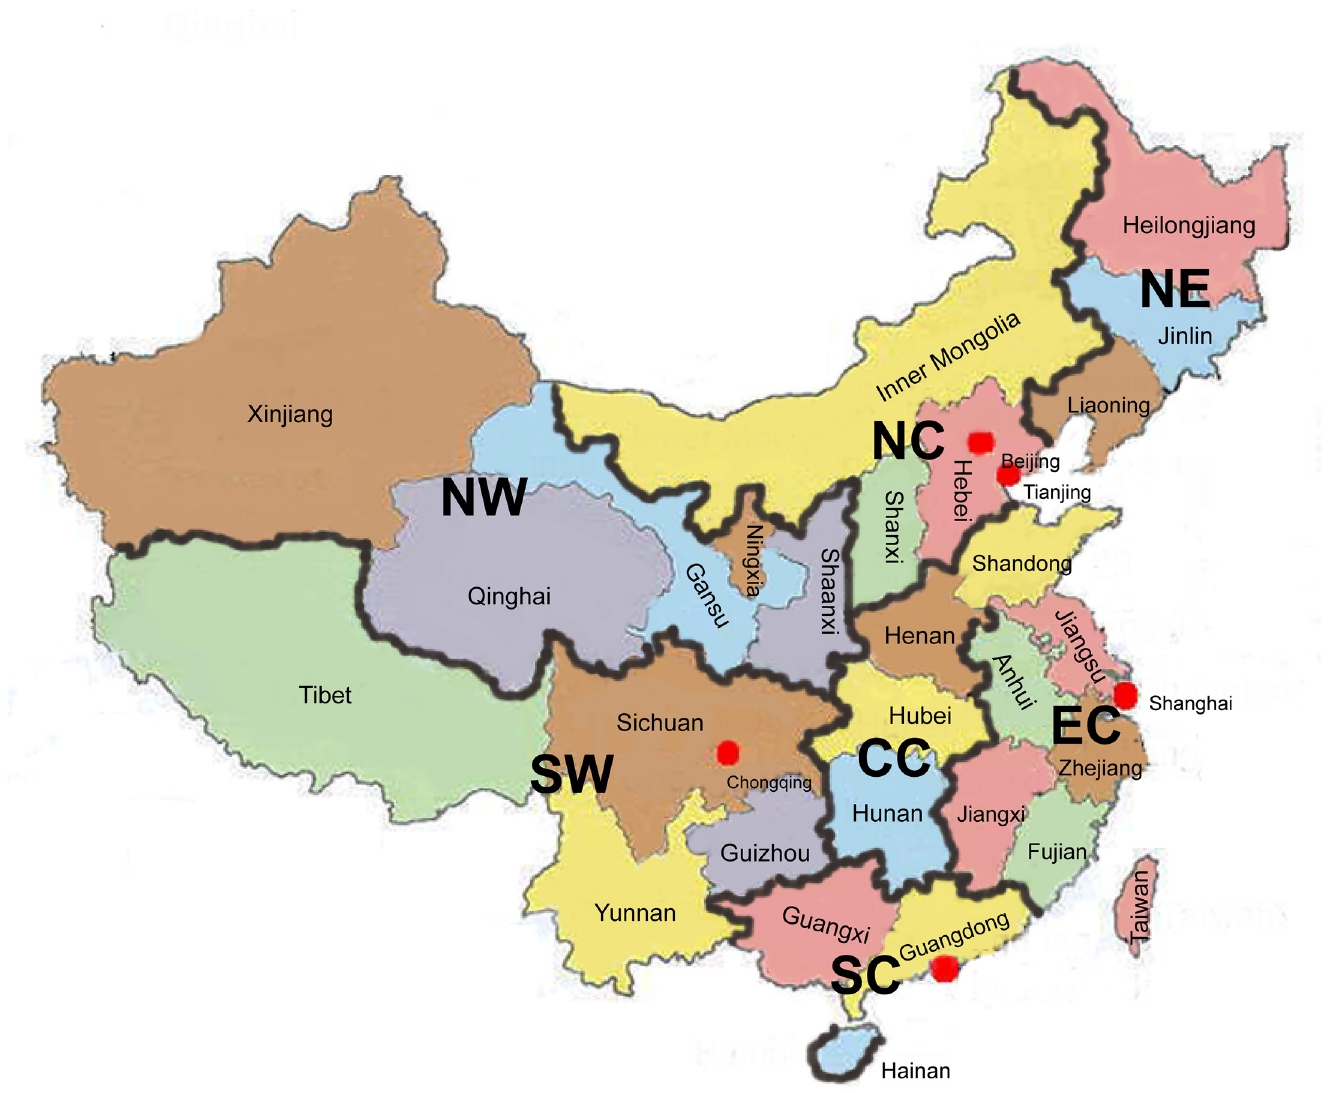
Fig 1. Geographic regions of China. Northeast China (NE), North China (NC), Northwest China (NW), East China (EC), Central China (CC), South China (SC), and Southwest China (SW). Note: Taiwan, Hong Kong and Macau were not included in this